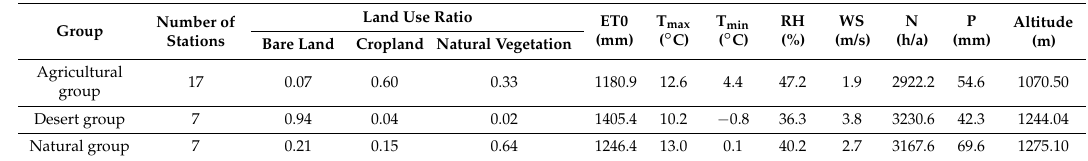
Table 2. General characteristics of the stations in different station